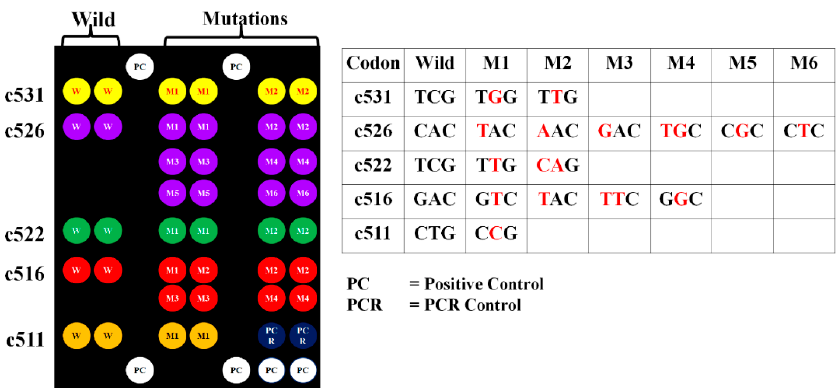
Figure 1. Respective positions of immobilized probes for codons c531, c526, c522, c516, and c511 (table on the right represents the corresponding wild and mutation sequence in these codons).